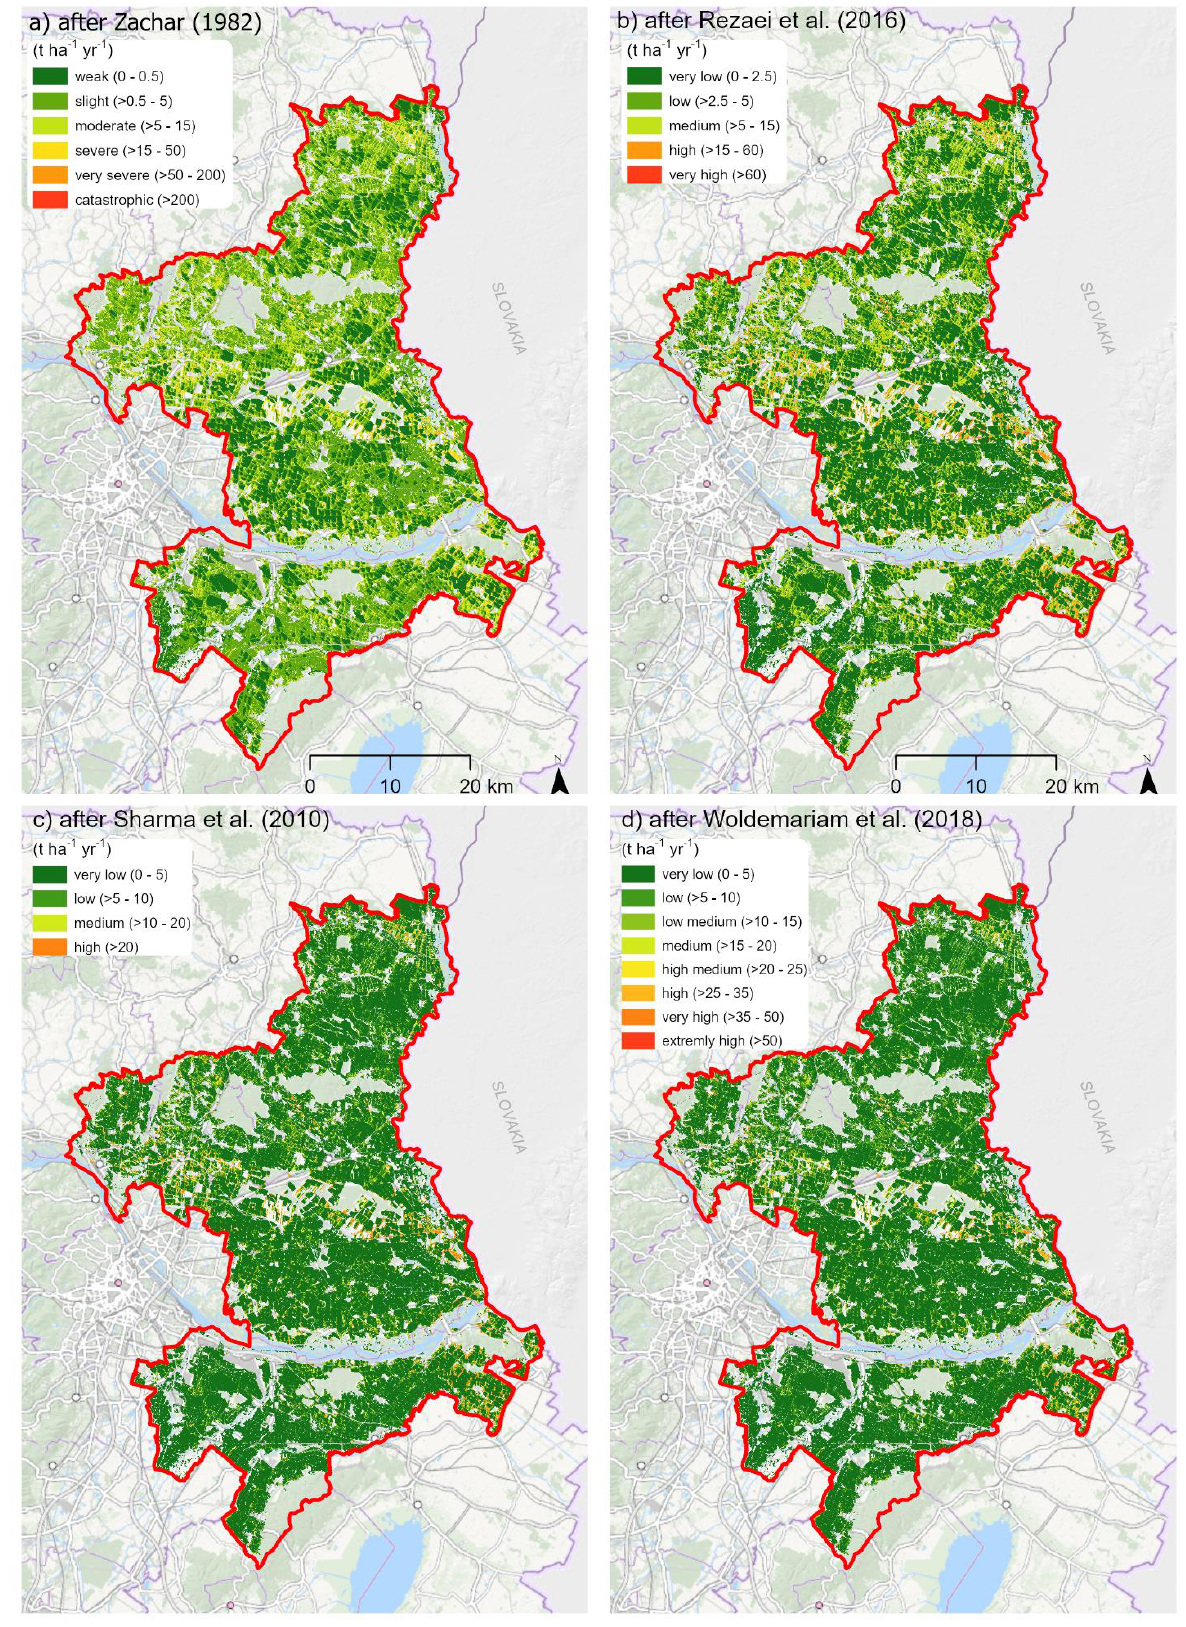
Figure 10. Different perceptions of soil erosion risk according to the choice of the classification scheme and severity classes. Classification schemes do not explicitly use wind erosion but general erosion classification limits (except [75]).